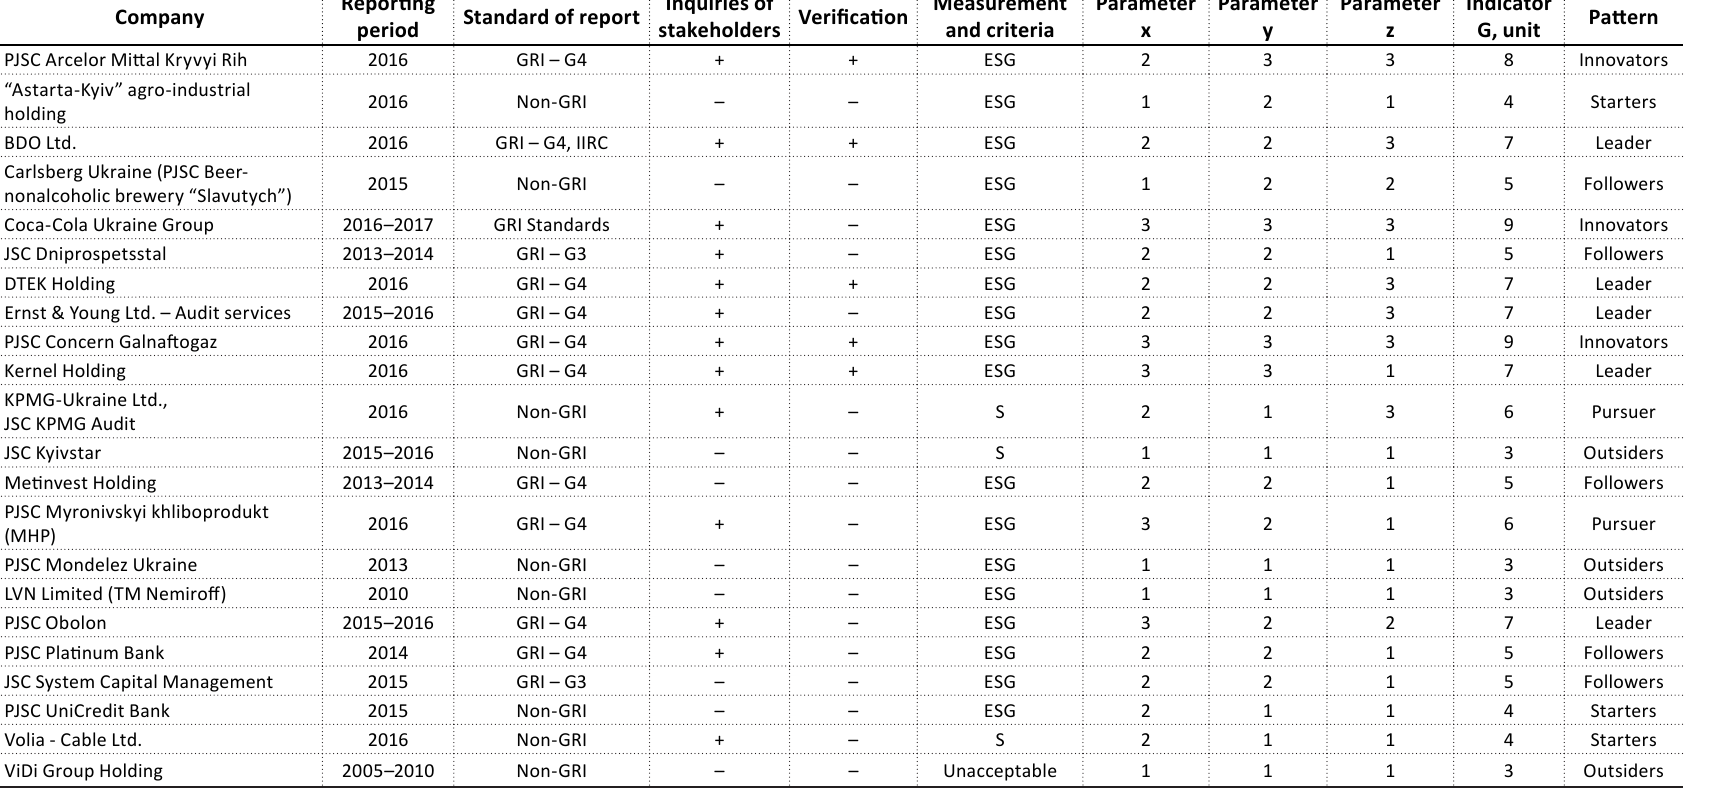
Table A1. The positioning of the Ukrainian companies by the parameters of information disclosure and by three-component indicator in 2005–2017